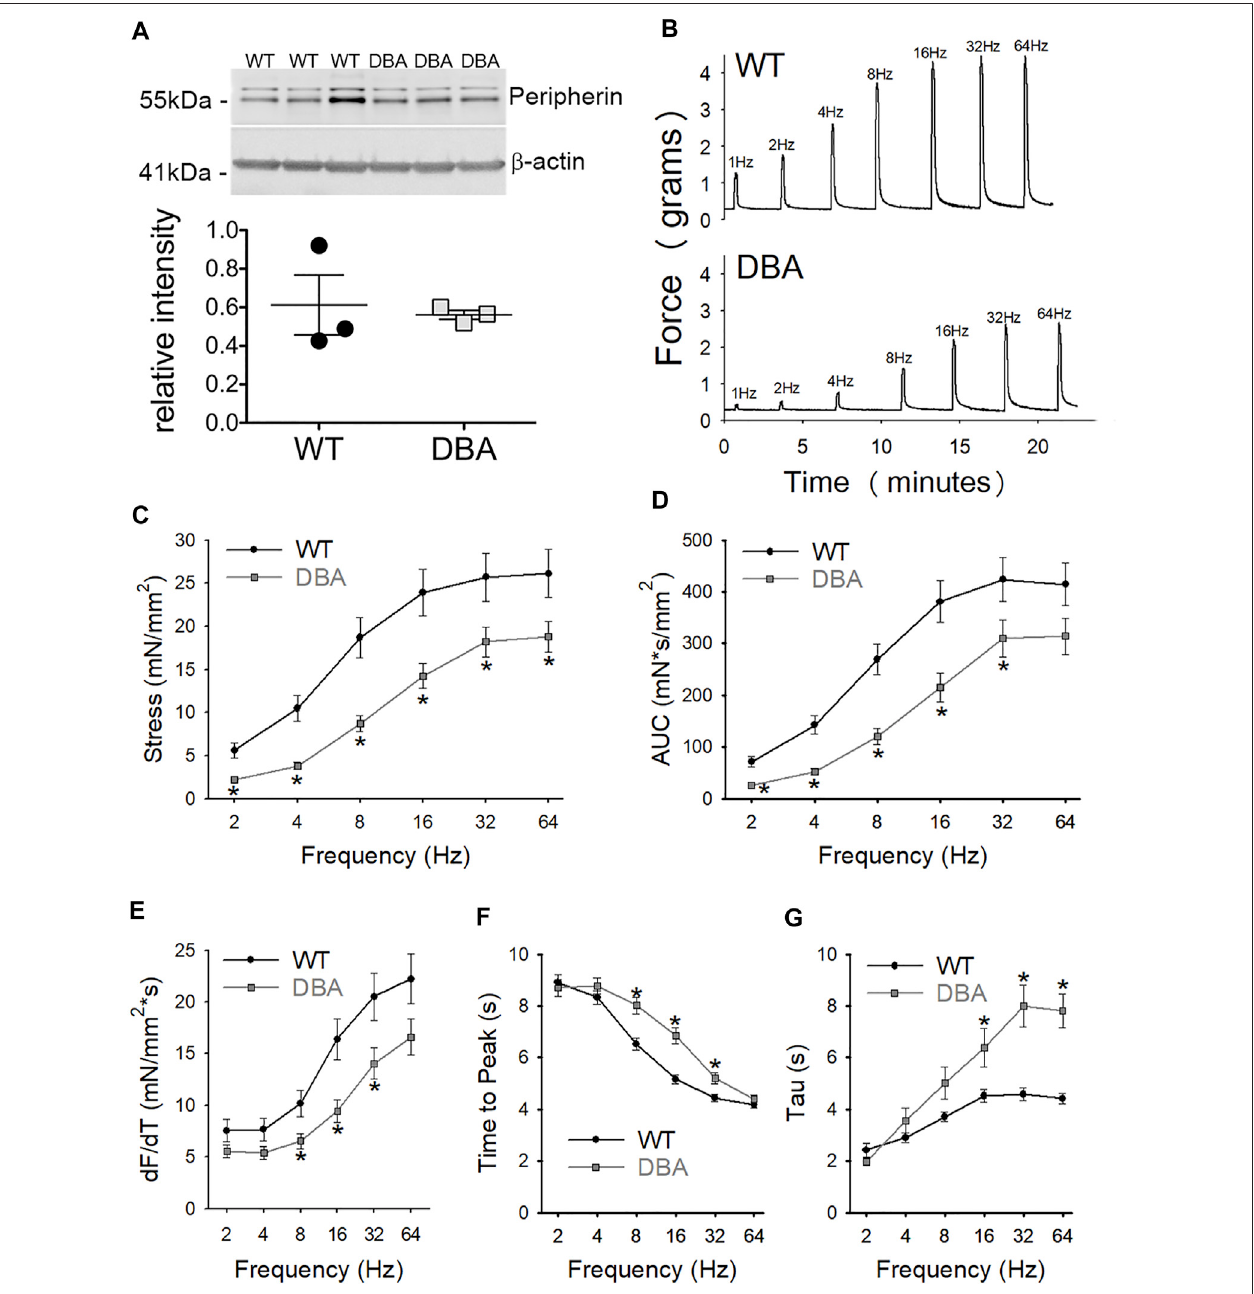
FIGURE 8 | Contractile responses to EFS in WT and DBA bladders. (A) Representative membrane and quantitative graph showing the expression of neuronal markerperipherininWT( N =3,blackcircles)andDBA( N =3,graysquares)detrusorlysates.Theintensityofbothimmunoreactivebands,correspondingtothe~56and ~58 kDa peripherin isoforms (Landon et al., 2000) were normalized by internal control β -actin. No differences in peripherin expression were detected between WT and DBA detrusors. (B) Representative tracing showing the contractile responses toEFS at frequencies between 2and 64 Hz in WT (top trace) vs. DBA (bottom trace) detrusors. (C) The amplitude and (D) the area under the curve (AUC) of EFS-induced contractions of WT (black circles) and DBA (gray squares) detrusor tissue are plotted. Contractile responses of DBA detrusor were signi fi cantly lower than that of WT detrusor over a range of frequencies, as indicated by the asterisks. (E) The peak rate of rise of the ascending phase of the contraction, (F) the time to peak, as well as (G) the rate of decay (Tau) of the descending phase of the neurogenic contractions aregraphedforWT(blackcircles)andDBA(graysquares)detrusors.Especiallyatmiddletohigherfrequenciesofstimulation,contractionsinDBAmiceweresigni fi cantly decreased in slope with delayed time to peak and prolonged recovery time, compared to those measured in WT ( N = 11 WT, N = 13 DBA; * p < 0.05).